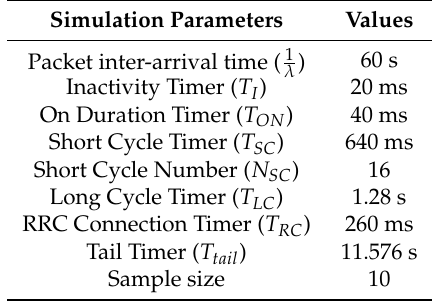
Table 4. List of DRX simulation parameters